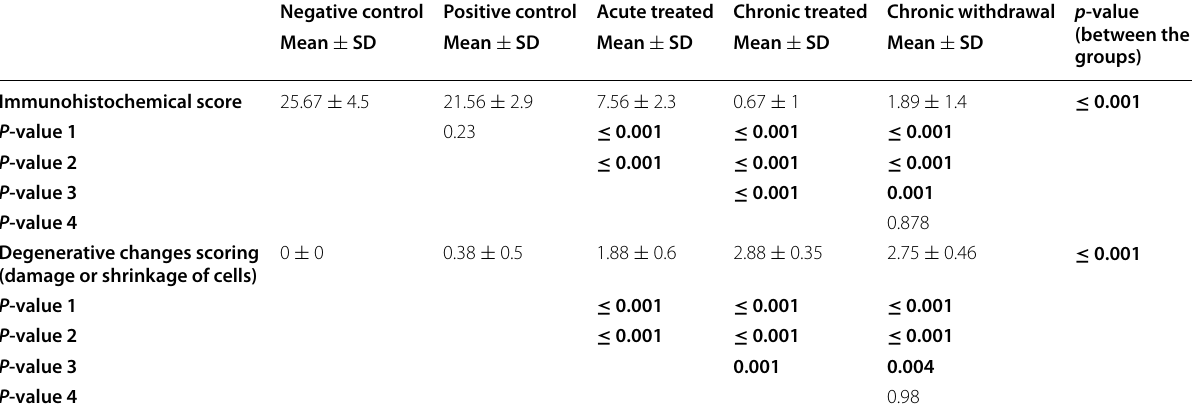
P1 , comparison between negative control and positive control, acute, chronic, chronic withdrawal groups; P2 , comparison between positive control and acute, chronic, chronic withdrawal groups; P3 , comparison between acute treated group and chronic and chronic withdrawal groups; P4 , comparison between chronic treated group and withdrawal group. SD , standard deviation, P -value < 0.05 considered statistically significant. ANOVA test was used to compare the mean difference between groups